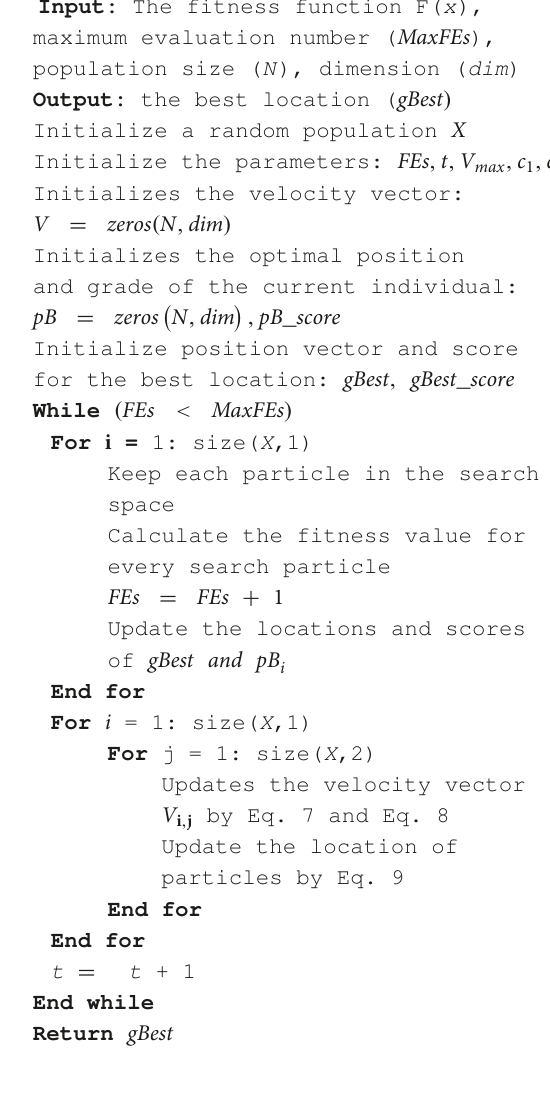
Algorithm 1 Pseudocode for the